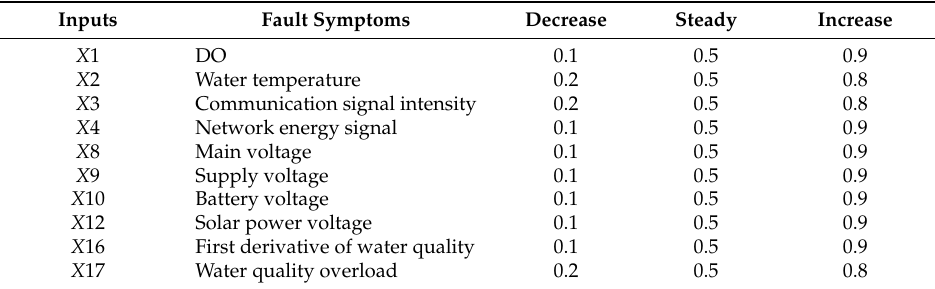
Table 3. The distribution of the fault degree of membership.